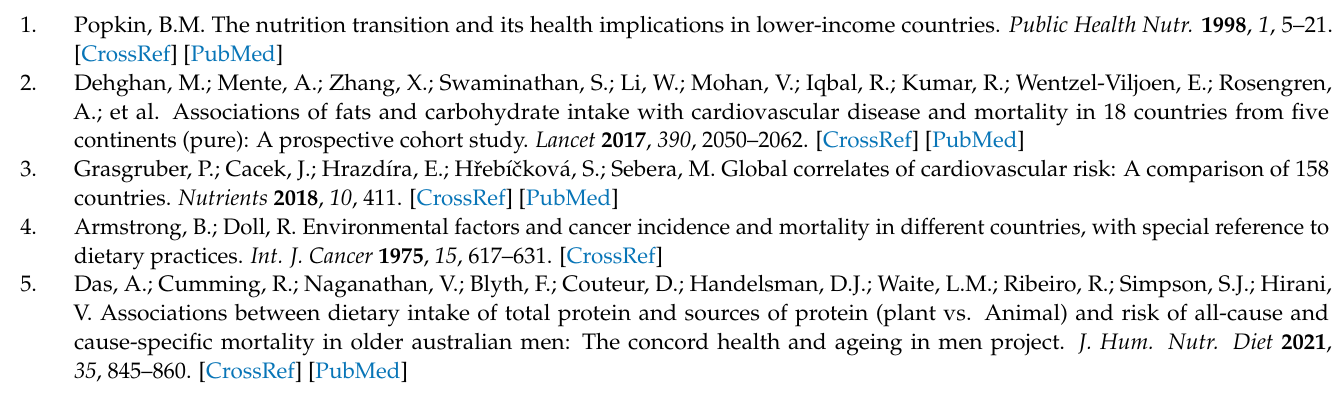
Table S4: Estimated hazard ratios for cancer mortality, in association with various pairwise macronu- trient substitutions (substitution of 3% of energy intake); Table S5: Scenarios for the association of 3% substitution of energy among macronutrients with all-cause mortality, cardiovascular mortality and cancer mortality after removing participants with diabetes; Table S6: Scenarios for the associ- ation of 3% substitution of energy among macronutrients with all-cause mortality, cardiovascular mortality and cancer mortality after adding red meat intake to the maximally adjusted risk models; Table S7: Scenarios for the association of 3% substitution of energy among macronutrients with all-cause mortality, cardiovascular mortality and cancer mortality using standard multivariate model (“S”